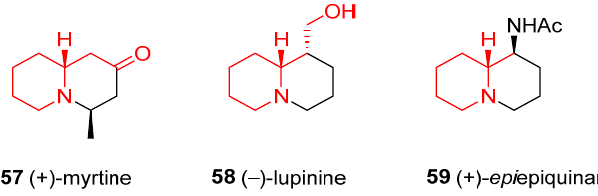
Figure 4. Structures of the alkaloids (+)-myrtine, ( − )-lupinine, and (+)- epi epiquinamide.